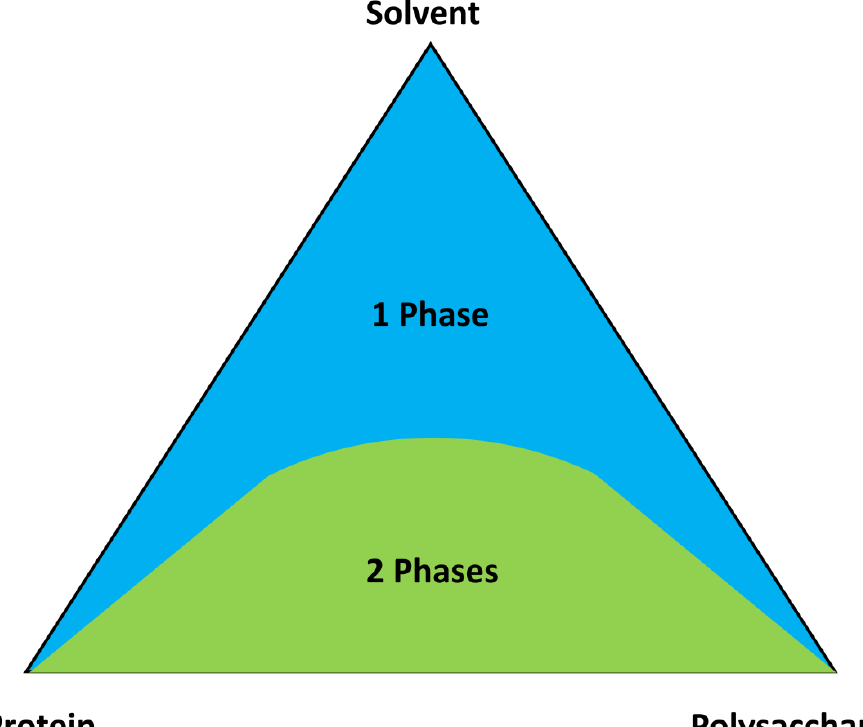
Figure 5. Ternary-phase diagram of a protein/polysaccharide solvent system.